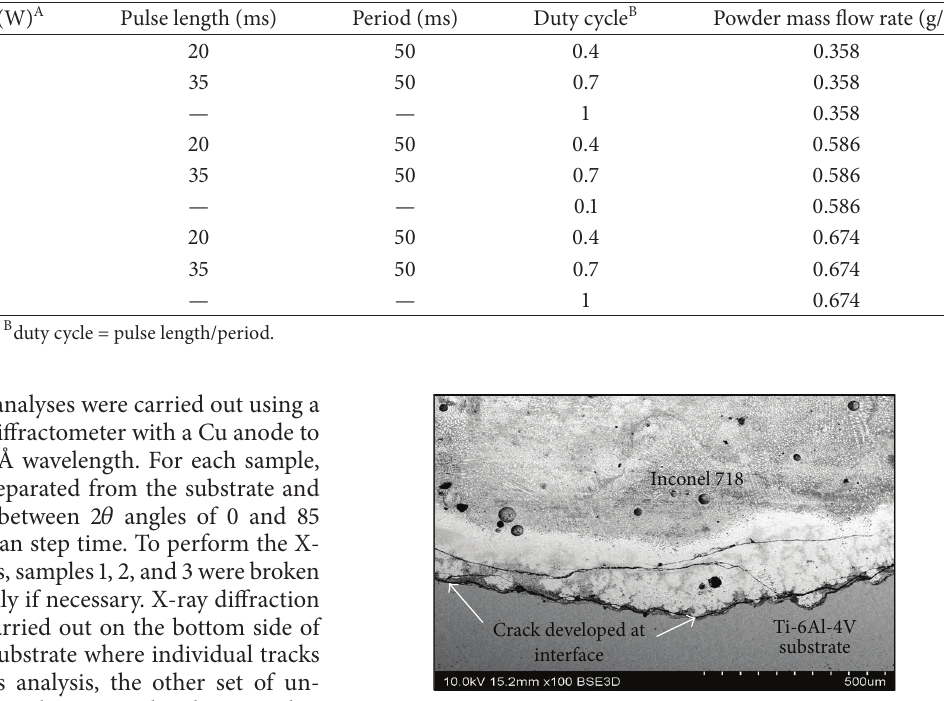
carried out to measure vertical “ 𝜎 residual stresses in the middle of the clad and along the track length of uncracked samples 1–3. The measured distributions are plotted for three different duty cycle depositions in Figures 5, 6, and 7,